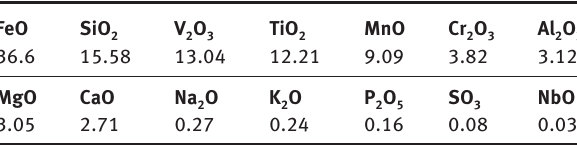
Table 1: Chemical composition of the vanadium slag (mass fraction, %) FeO SiO 2 V 2 O 3 TiO 2 MnO Cr 2 O 3 Al 2 O 3 36.6